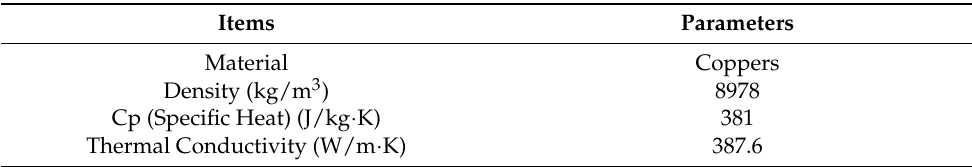
Table 4. The details of the copper